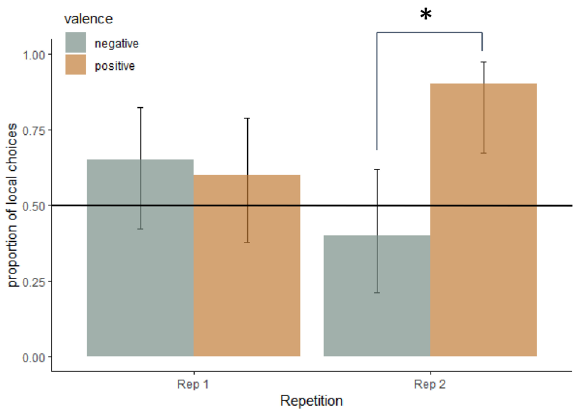
Figure 4. The effect of the valence and repetition (Table 1) on the proportion of local choices (predicted means ± CI) in the conflict test. Asterisk: indicates a difference between positive and negative valence conditions in the second repetition (P < 0.05). The line indicates 0.5 proportion of local